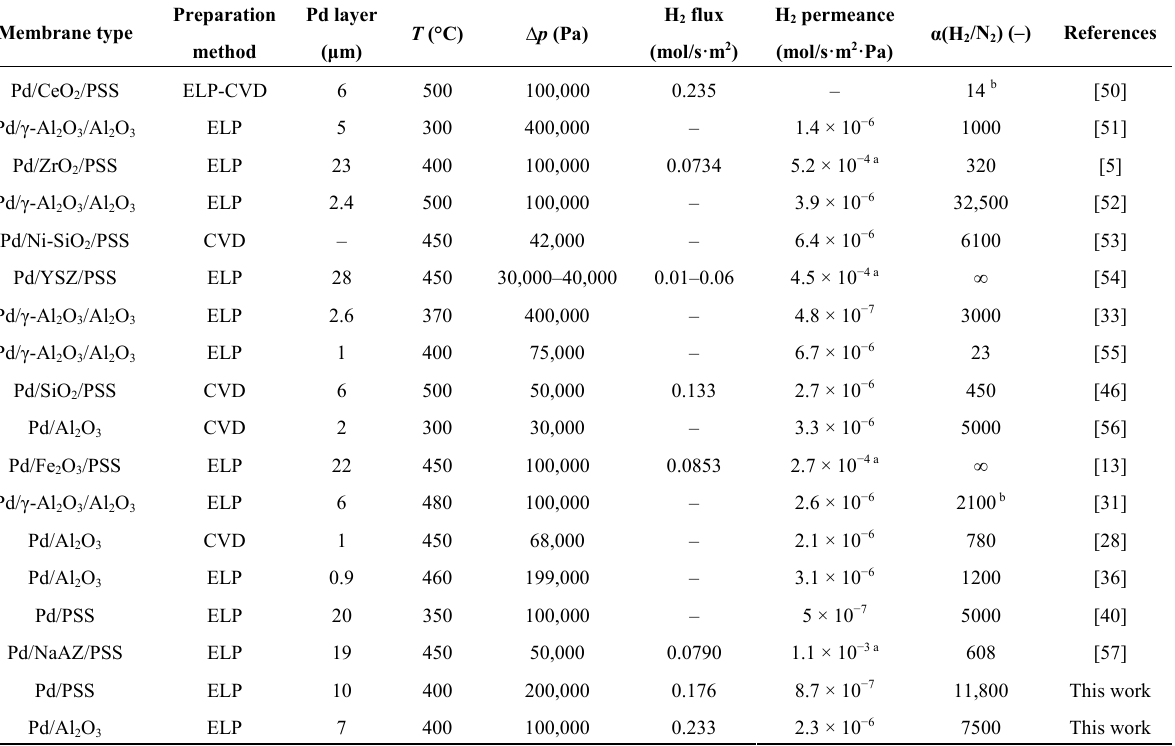
Table 3. Comparison with scientific literature